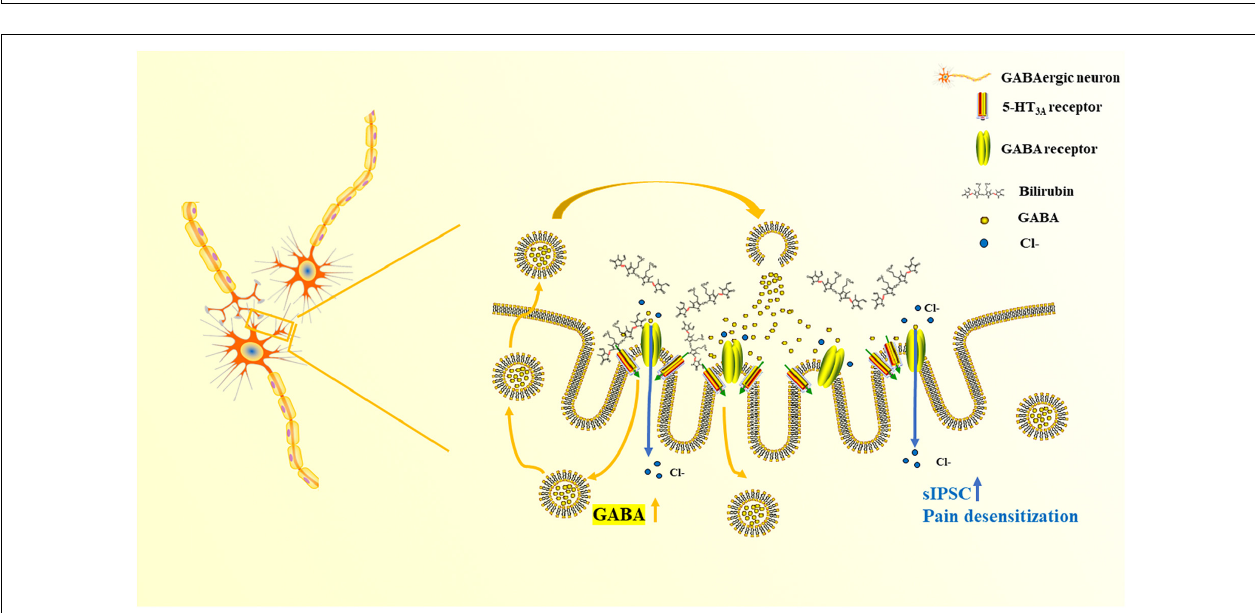
FIGURE 7 | Bilirubin increased the activity of sIPSC of GABAergic neurons. (A) Both 0.2 µ M of mCPBG and 10 µ M of bilirubin enhanced the activity of GABAergic sIPSC significantly. (B) The enlargement of currents by ACSF, mCPBG, and bilirubin perfusion. (C) No differences were observed by mCPBG or bilirubin intervention in the presence of ondansetron perfusion in GABAergic sIPSC. (D) Histogram of the frequency and amplitude of GABAergic sIPSC changed by mCPBG and bilirubin with or without ondansetron intervention. * P < 0.05; # P < 0.05.